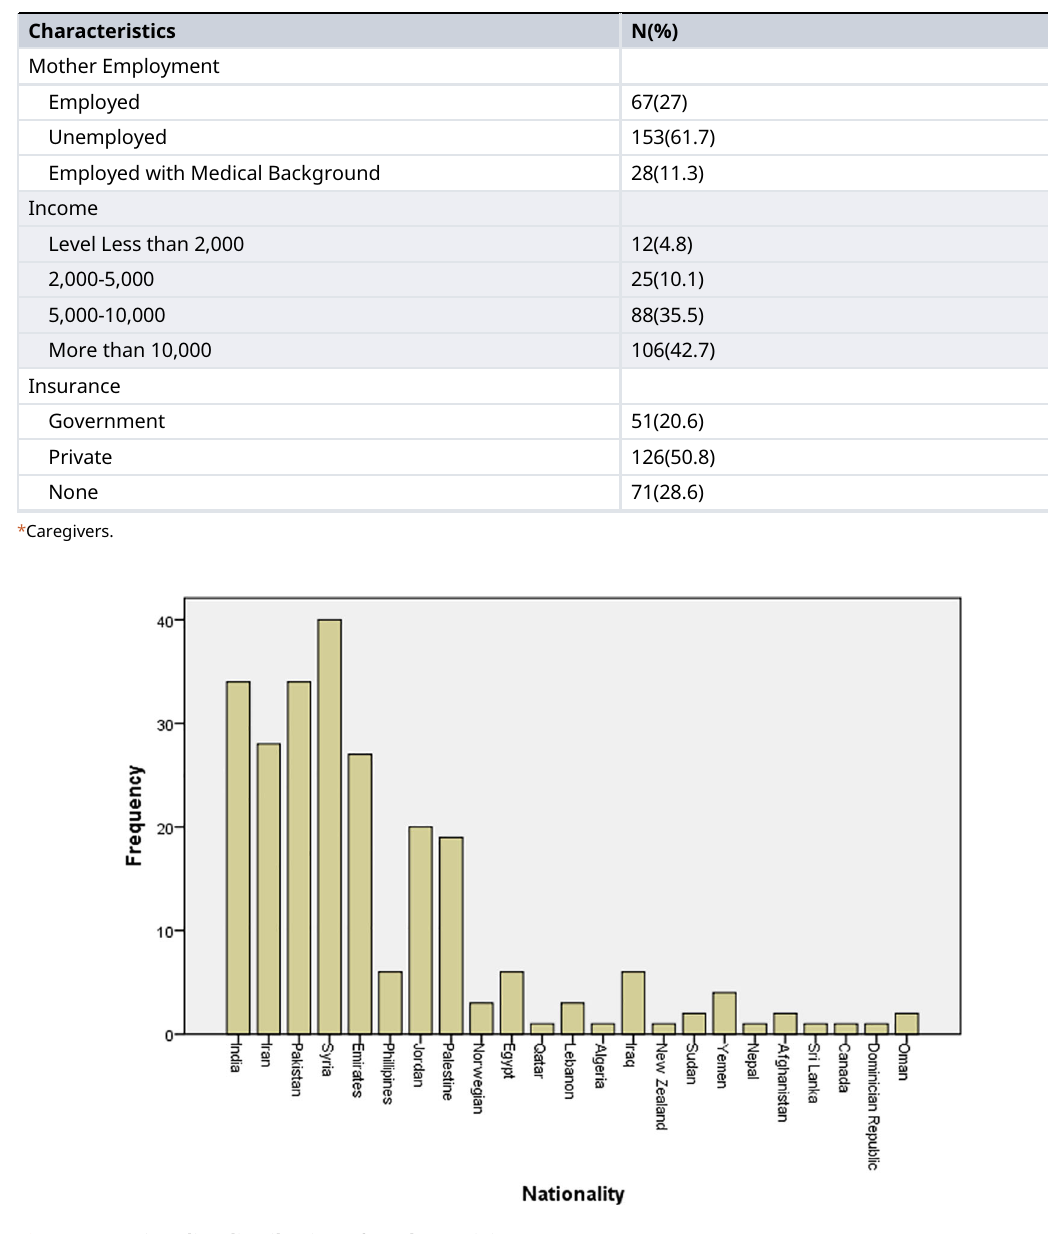
Figure 1. Nationality distribution of study participants.